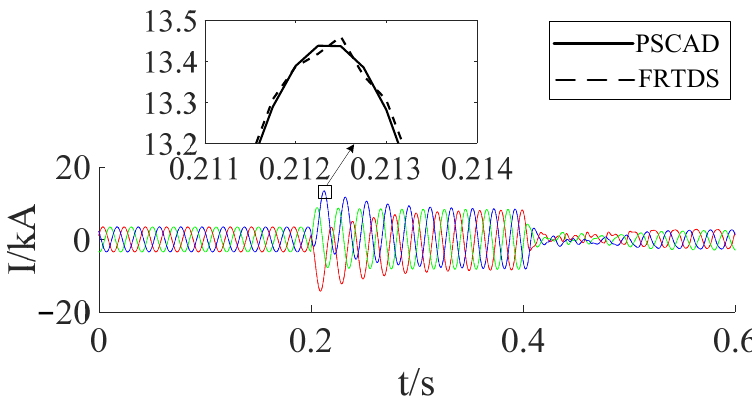
Figure 12. Waveform of AC current at inverter side in the FPGA and PSCAD.